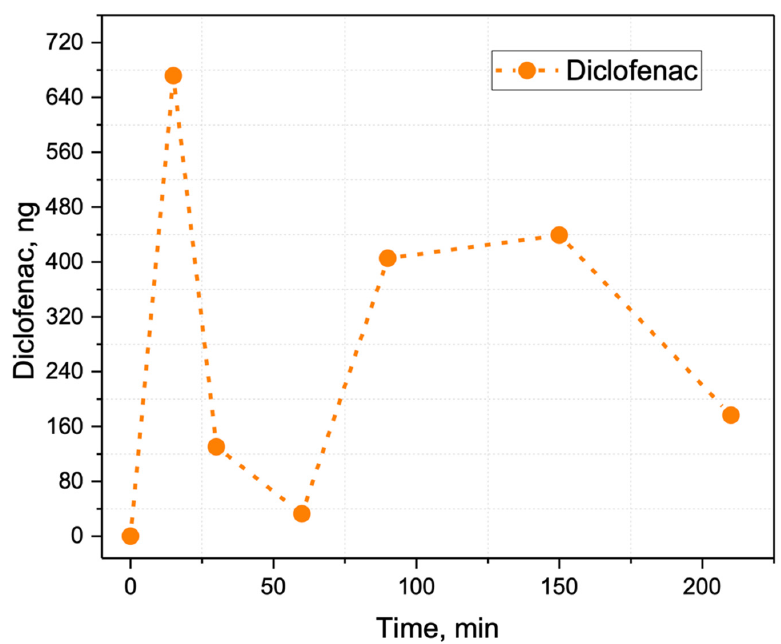
Figure 10. Relative change in diclofenac content in human sebum after applying a diclofenac salve. At 15 min, the diclofenac was detected as it was released from the blood while transporting from the application area. After 60 min, the diclofenac accumulated in synovial fluid releases through the skin.